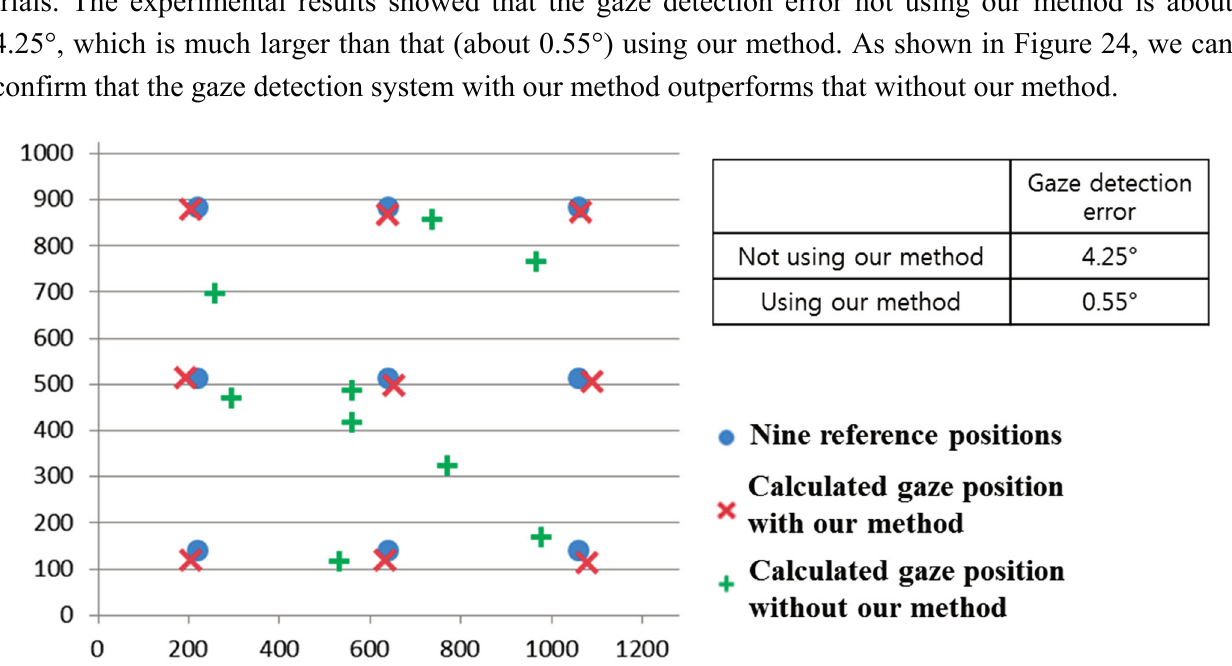
Figure 24. Comparisons of gaze detection errors without and with our method of removing the region of background external light as shown in Section